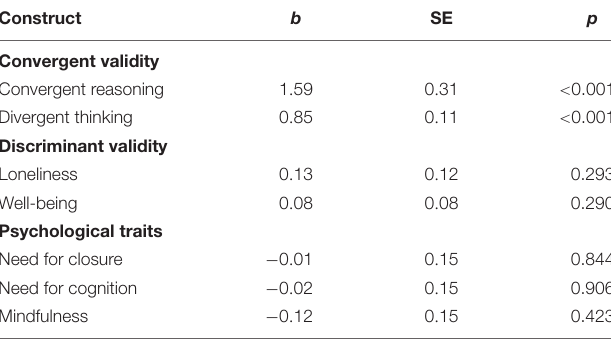
TABLE 7 | ANTA linear regression